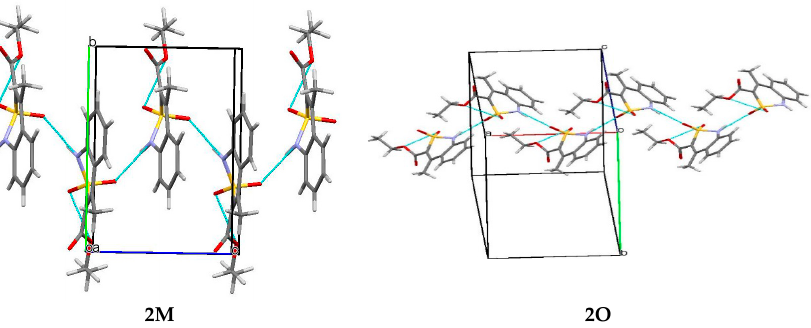
Figure 5. The chains of ethyl 4-methyl-2,2-dioxo-1 H -2 λ 6 ,1-benzothiazine-3-carboxylate molecules in the monoclinic 2M ( left ) and orthorhombic 2O ( right ) polymorphic forms.